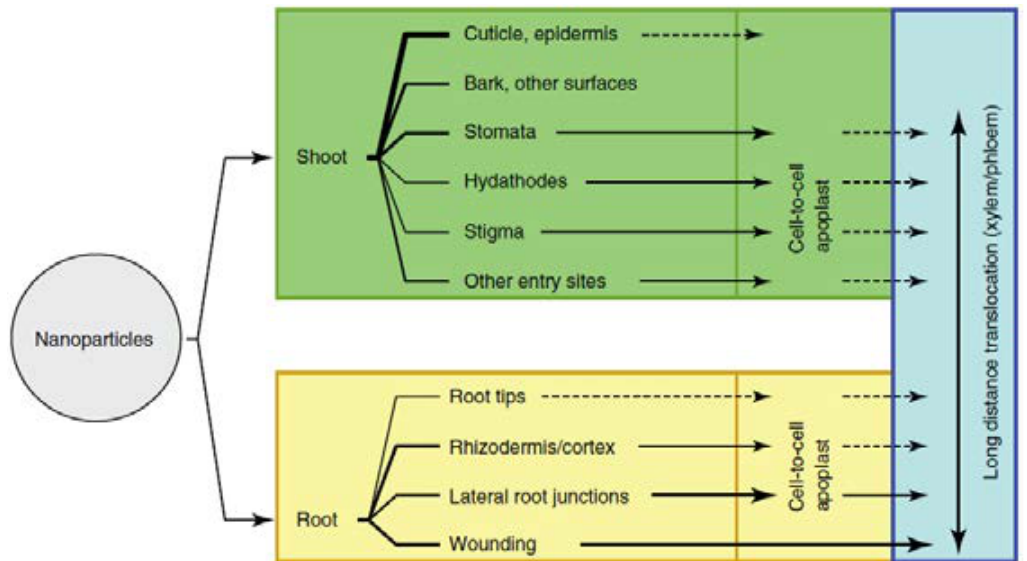
Fig. 2: Pathways of nanoparticle association, uptake, and translocation in plants. The assumed significance of the pathways is represented by the line thickness and the assumption of very low rates of transport is indicated by broken line (Dietz and Herth, 2011)